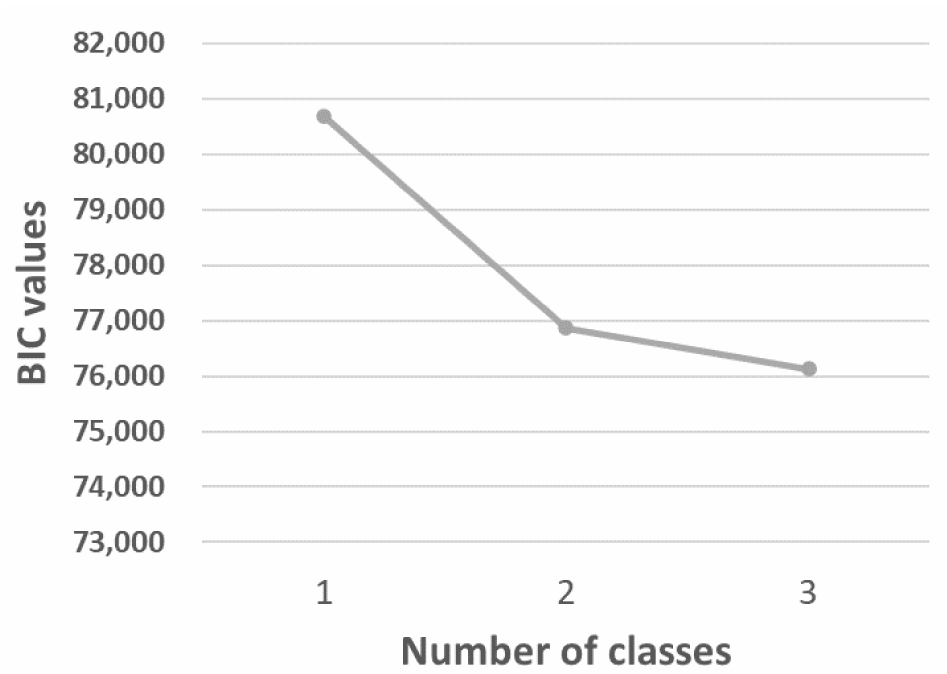
Figure 3. Scree plot of BIC values from Latent Class Analyses with one to three